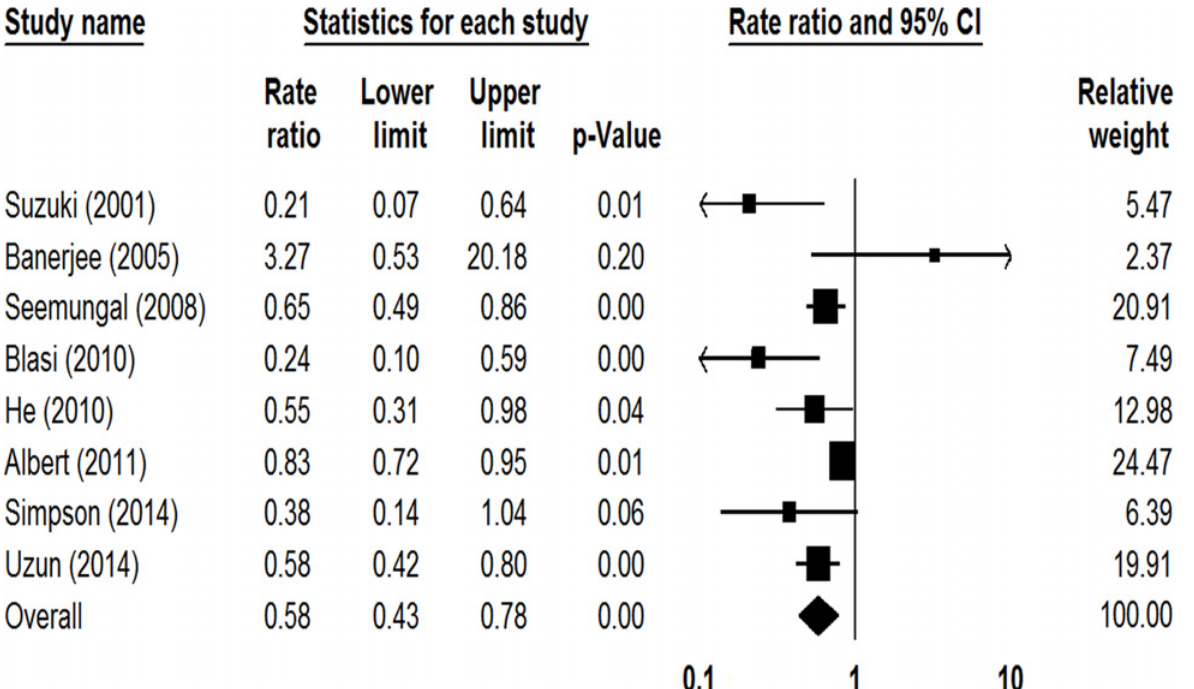
Fig 3. Forest plot of risk ratios for exacerbations per patient per year treated with macrolides compared with the control.